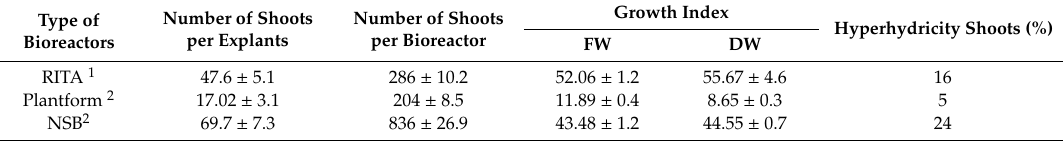
Table 1. The growth parameters of transformed shoot culture of Dracocephalum forrestii after 3 weeks in di ff erent bioreactor systems in MS (Murashige and Skoog) medium with 0.5 mg / L BPA and 0.2 mg / L